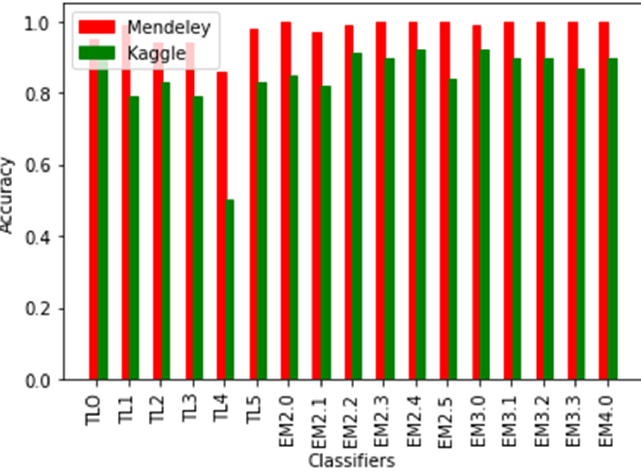
Figure 12. Average accuracy of various classifiers.